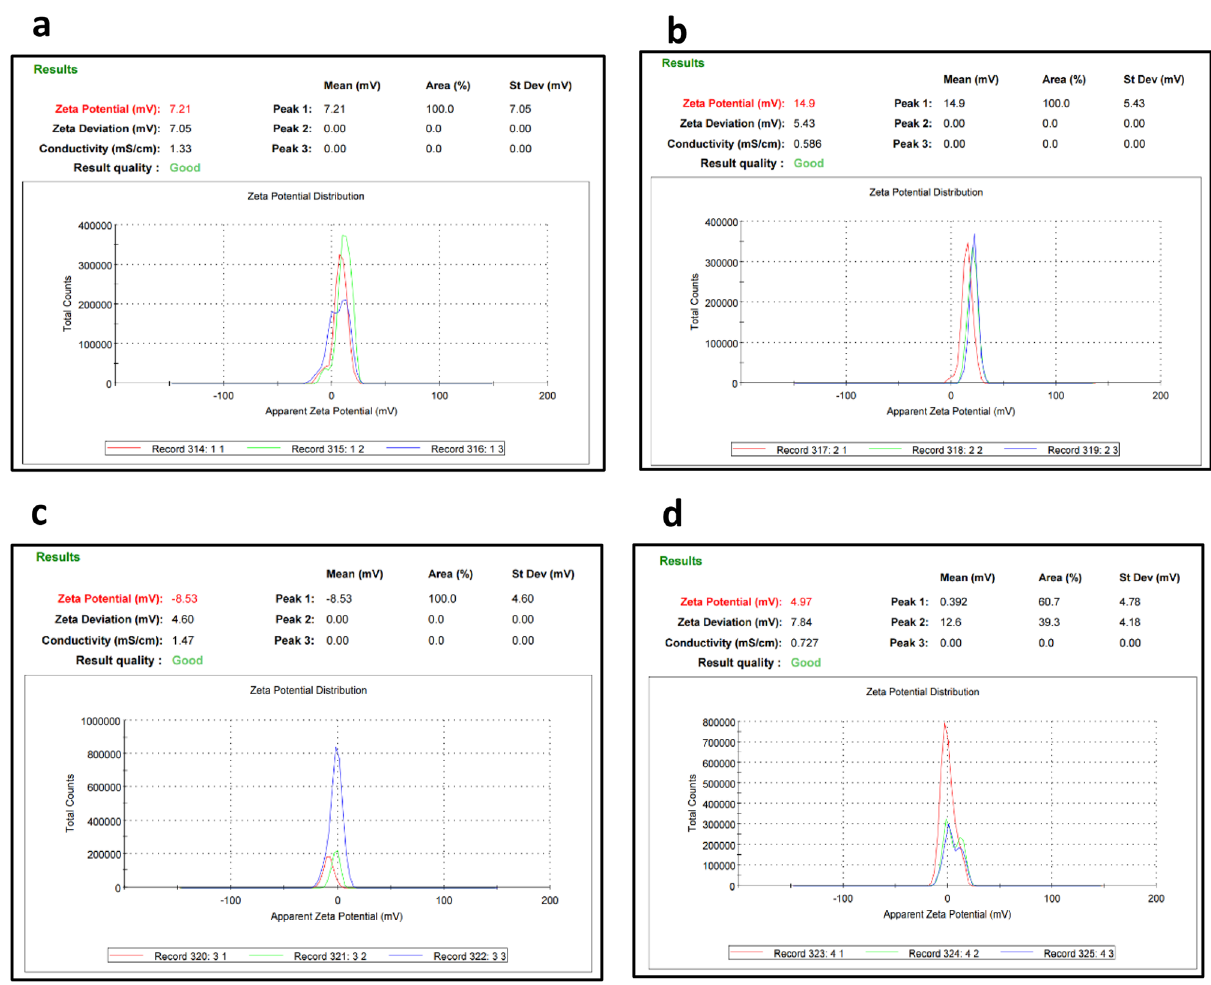
Figure 3. Zeta-potential measurements of ( a ) RFA, ( b ) BM, ( c ) BMN, and ( d )